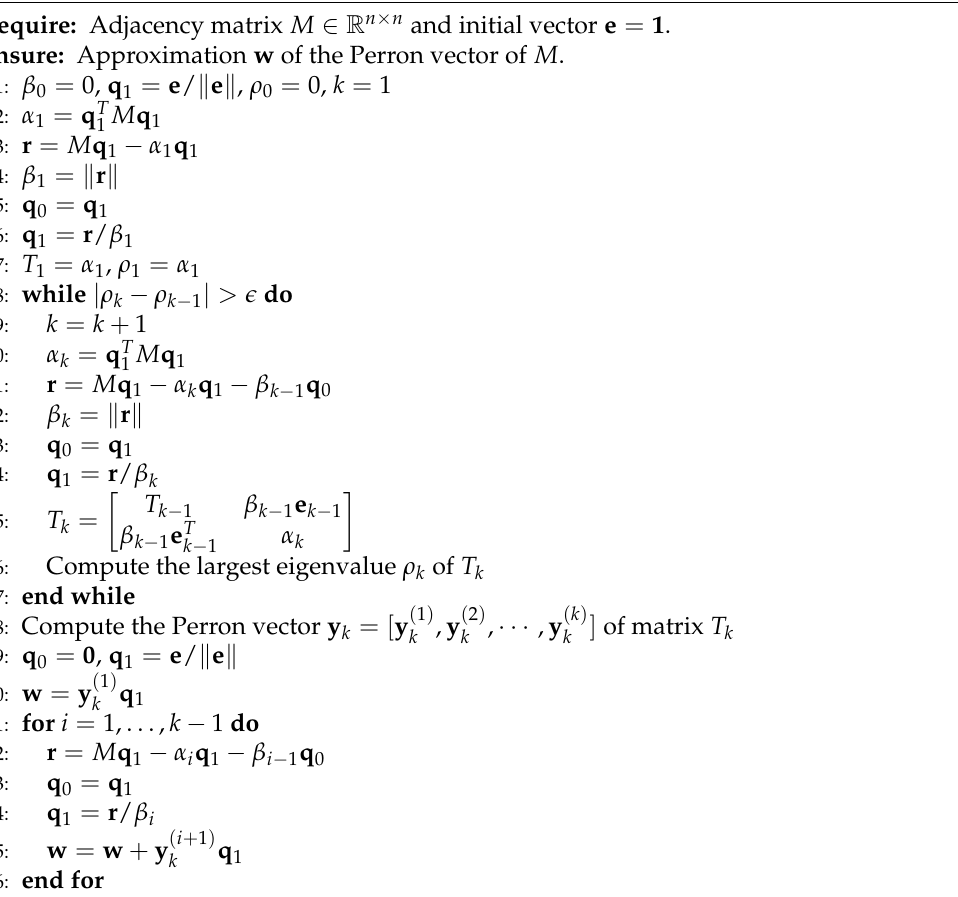
Algorithm 2 Determine the Perron vector of the matrix M by applying twice the Lanczos